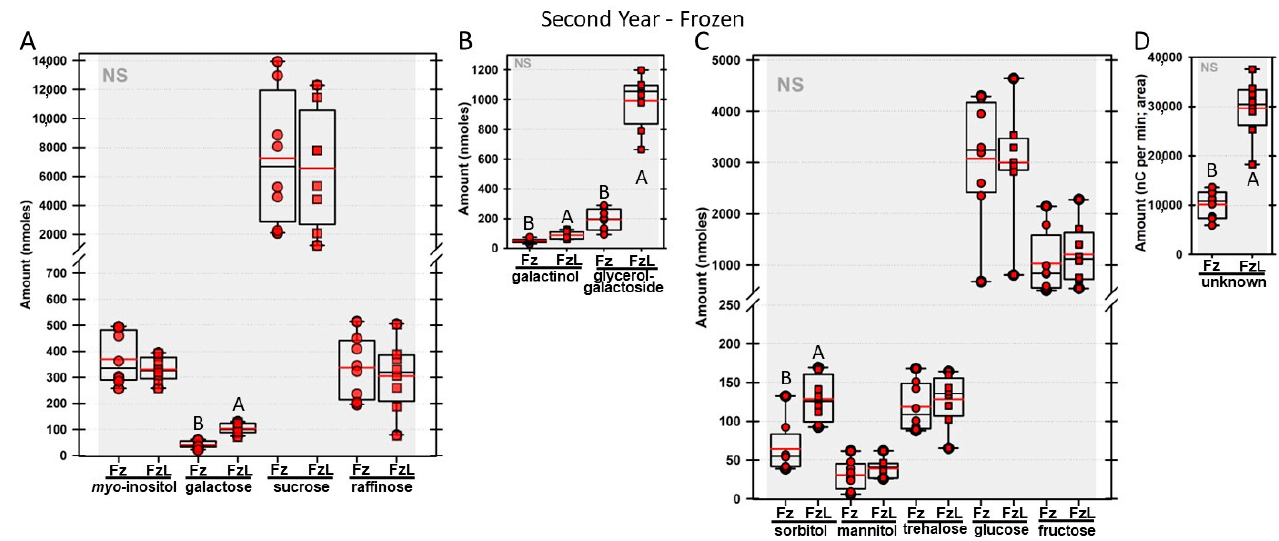
Figure 6. For a second year, carbohydrates were analyzed from null segregant (NS) maize leaves. The disks were frozen after harvest (Fz; red circles) or were frozen and then lyophilized to dryness (FzL = frozen lyophilized; red squares). The same carbohydrates are depicted, and statistically significant differences are determined in the same manner, as in Figure 4.